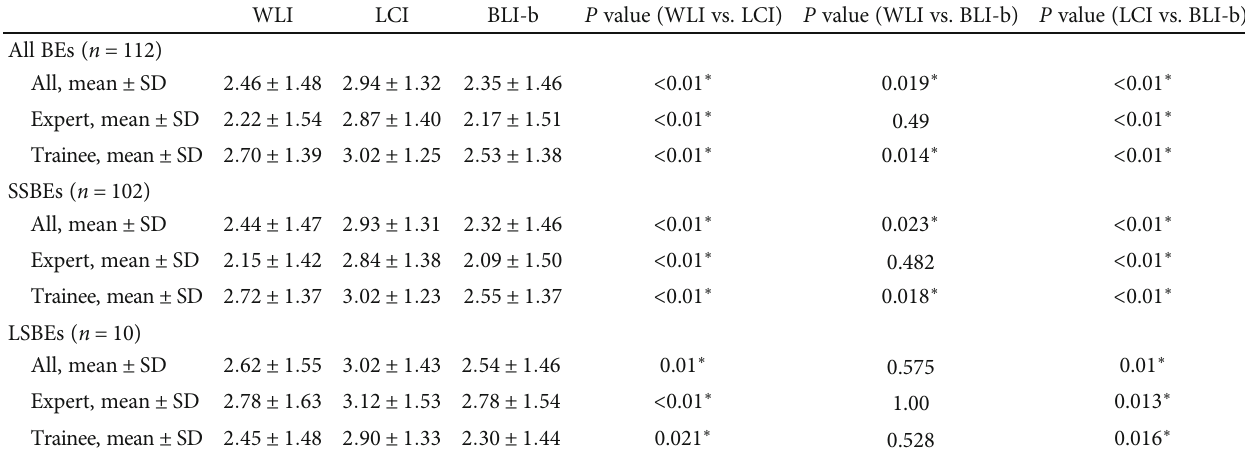
Table 2: The mean visibility scores of BE in WLI, LCI, and BLI-b modes.